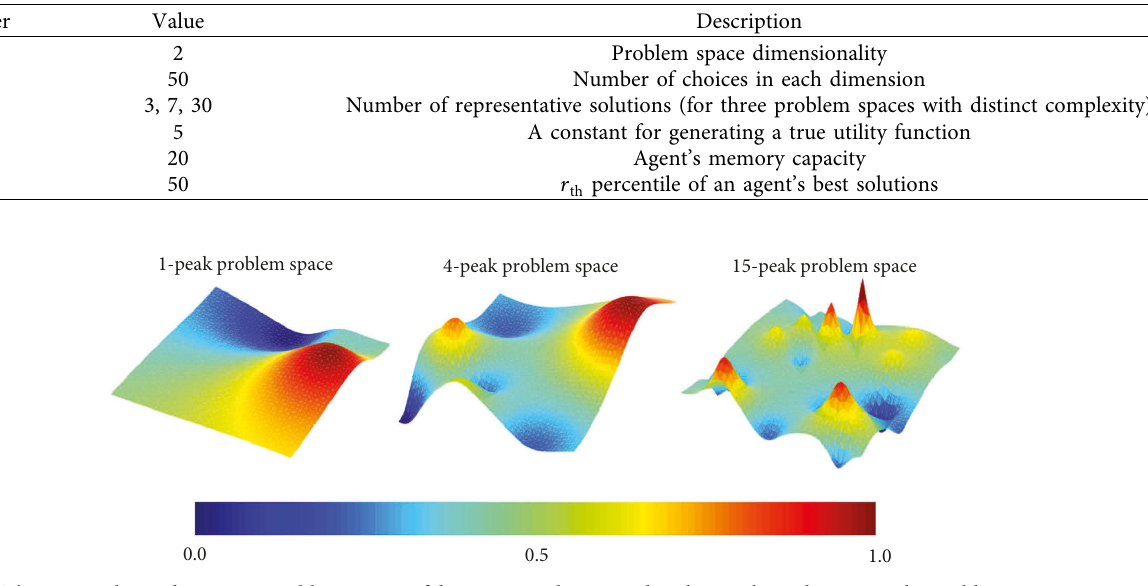
Figure 4: Three typical two-dimension problem spaces of distinct complexity used in this work. Each point in the problem space represents a solution, while the corresponding color denotes the value of the point. For example, dark red refers to a high value, whereas dark blue refers to a low value. Those points on the corners or on the boundaries of the problem spaces can also be the peaks. Meanwhile, a few of the peaks may not be observable in this